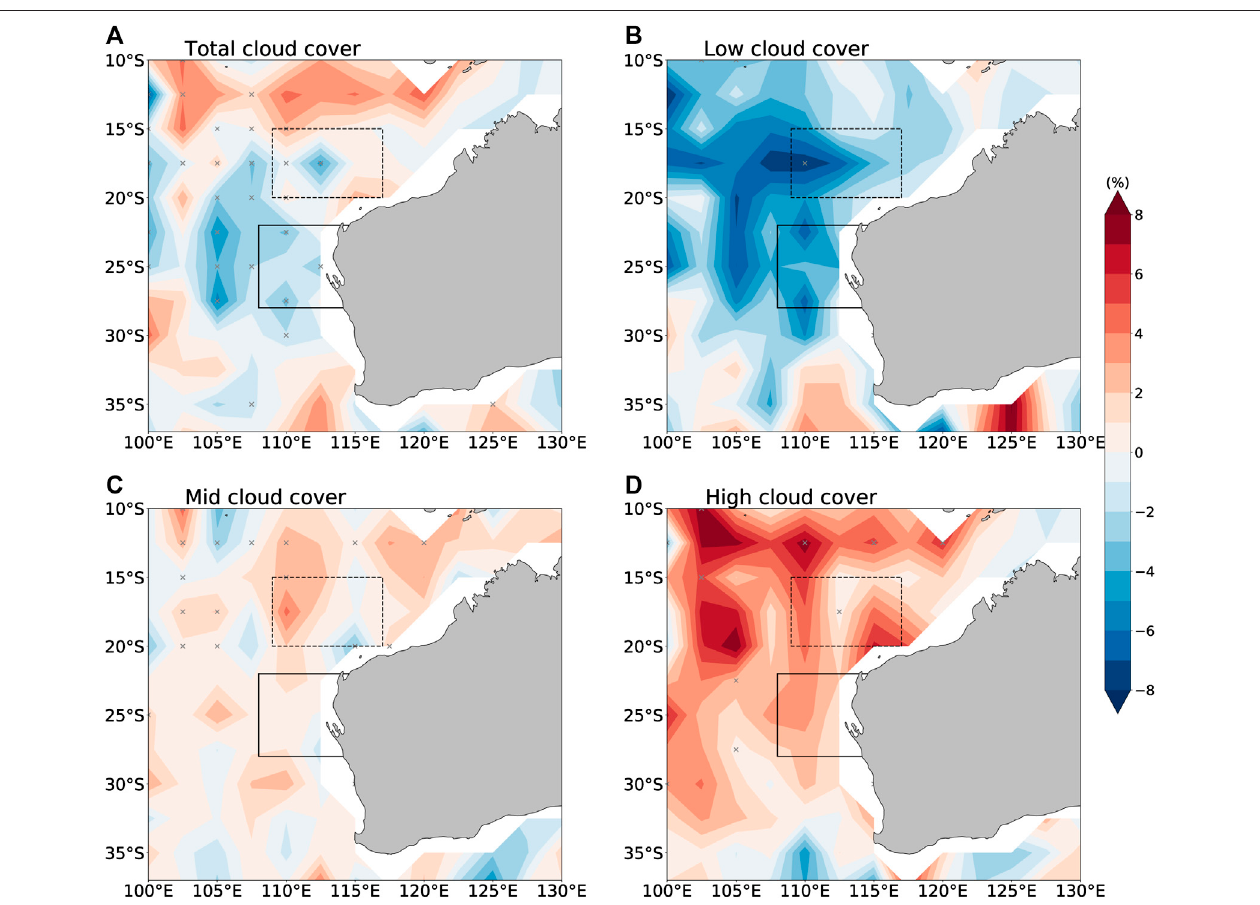
FIGURE 3 | Linear regressions of the austral summer (DJF) mean (A) total cloud cover (%), (B) low cloud cover (%), (C) middle cloud cover (%), and (D) high cloud cover (%) against PC1 during 2007 – 2017. The gray crosses indicate the variable anomalies above the 90% signi fi cance level by a Student t test. The solid and dashed boxes indicate the WA (108 ° E-coast, 28 – 22 ° S) and NWA (109 – 117 ° E, 20 – 15 ° S) coastal regions, respectively.